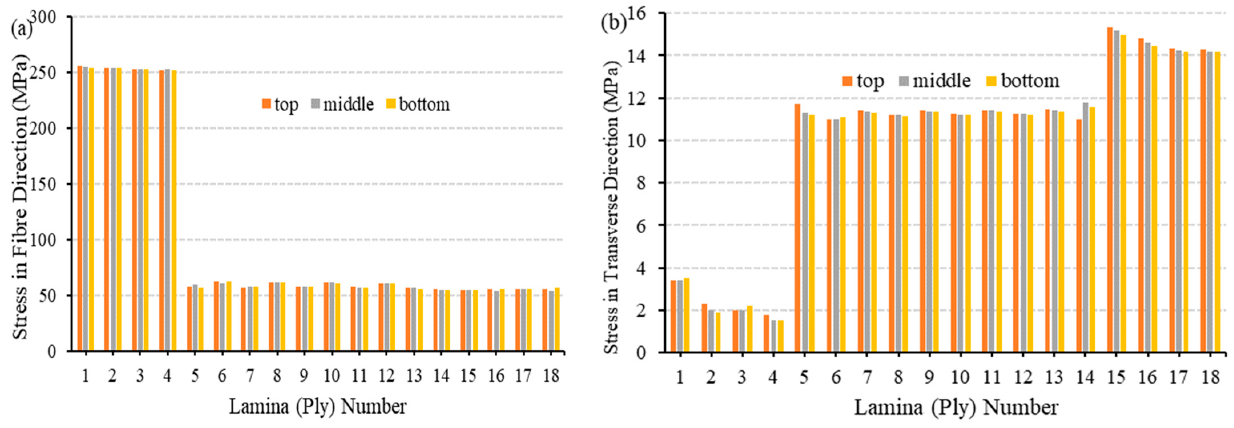
Table 10. Riser deformation and liner stress during tension event’s preliminary design.